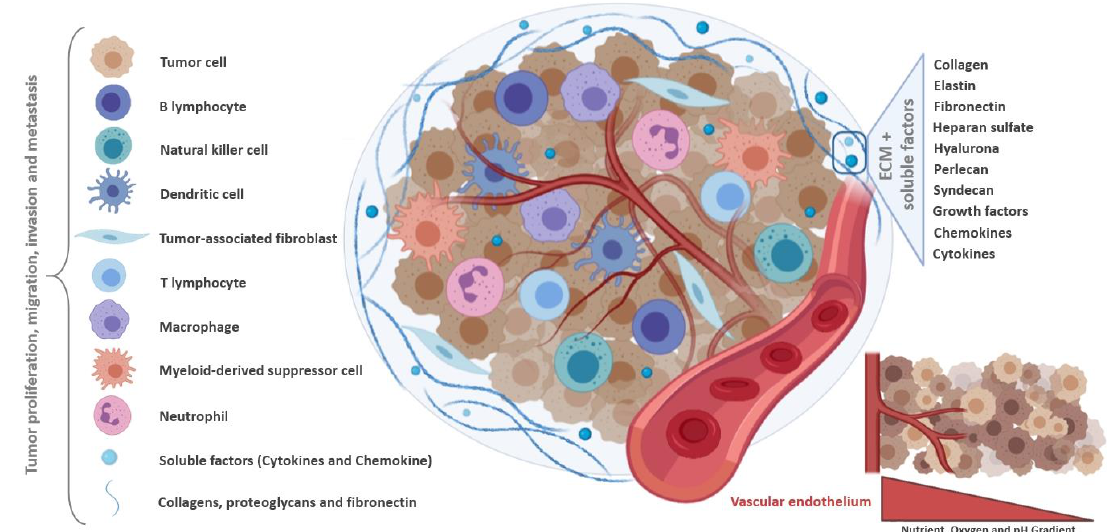
Figure 1. Schematic representation of the tumor microenvironment. The tumor ecosystem consists of a heterogeneous population formed by cancer and infiltrating immune cells, including tumor-associated fibroblasts, myeloid-derived suppressor cells and immune cells. The cross-talk between all these tumor microenvironment components play an essential role in tumor growth, development and metastasis, under hostile conditions. Soluble factors are constantly produced, triggering immunosuppressive responses and tumor survival. Created with BioRender.com.